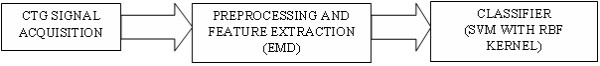
Proposed methodology. Stages involved in the proposed methodology